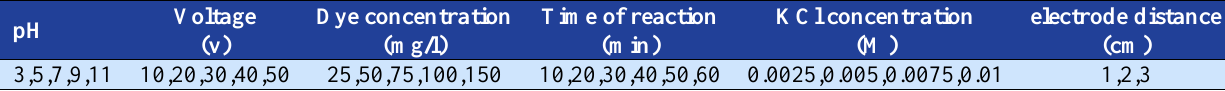
Table 1. The ranges of experimental